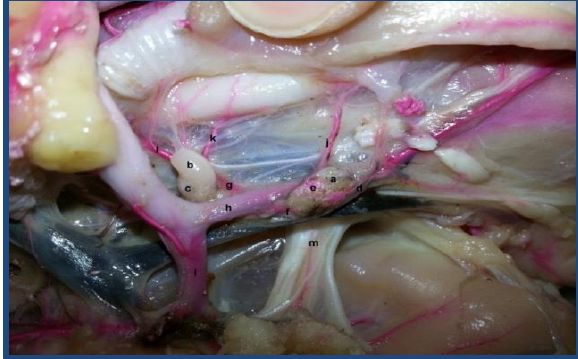
Figure, 4: Photograph in the left side of thoracic inlet showed: a-Thyroid gland b-Parathyroid gland c-Ultimobranchial gland d- Cranial thyroid artery e-Middle thyroid artery f-Caudal thyroid artery g-Esophagotracheobranchial artery h-common carotid artery i-Subclavian artery j-Ascending esophageal artery k-Esophageal branch l-tracheal and syringical branch m-Brachial plexus.